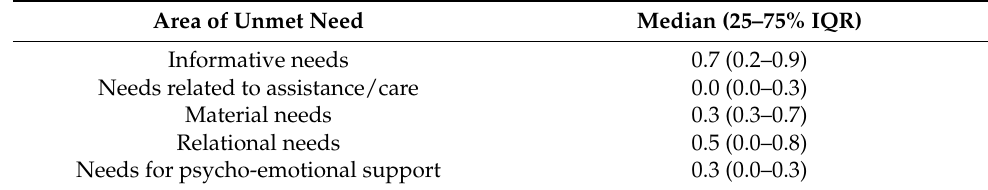
Table 2. Male lung cancer patients’ needs in five areas of unmet